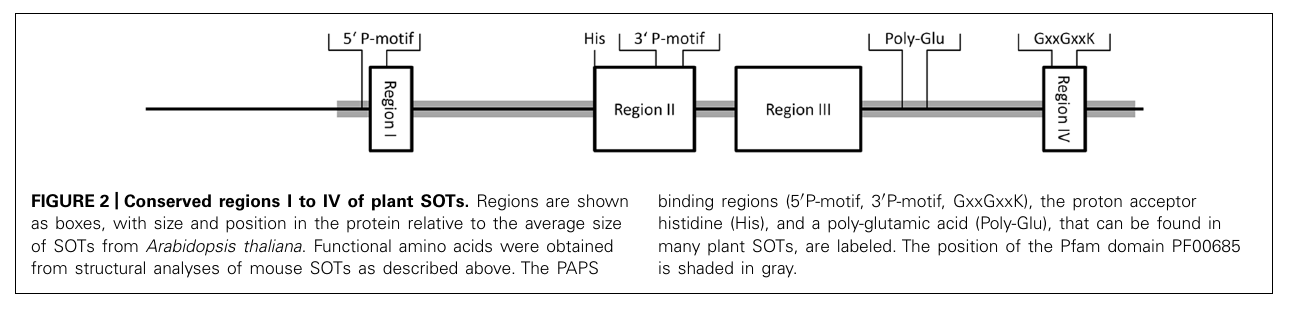
Table 1 | Summary of the members of the SOT family in Arabidopsis and their putative